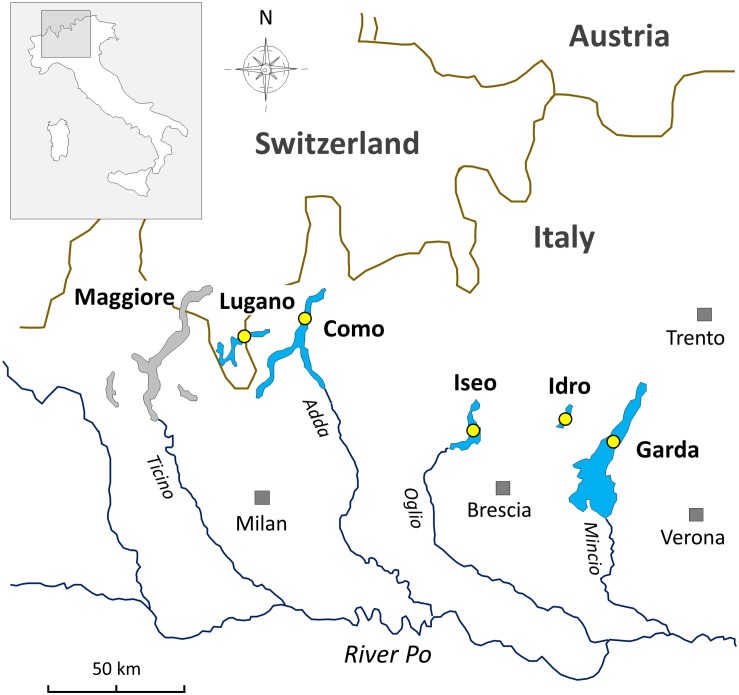
Geographical location of the deep southern perialpine lakes (DSL) investigated in this work. The yellow circles indicate the sampling points.